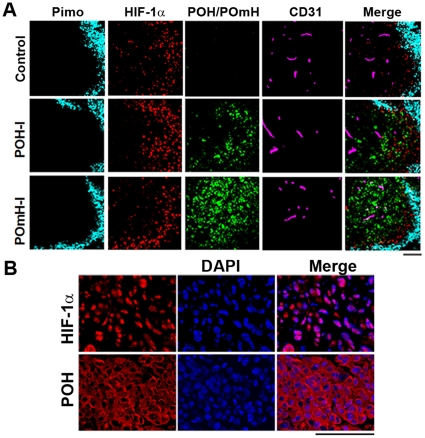
Intratumoral localization of POH probe.(A) Immunohistochemical analyses of SUIT-2/HRE-Luc xenografts. Tumors were removed 6 h after POH-I or POmH-I administration and examined for sever hypoxic regions (Pimo), HIF (+) cells (HIF-1α), probes (POH/POmH) and blood vessel (CD31). Bars  = 100 µm. (B) Cellular localization of HIF-1α and POH. Tumors were excised 6 h after probe injection and examined for cell nuclei (DAPI) and HIF-1α or POH. Bars  = 100 µm.